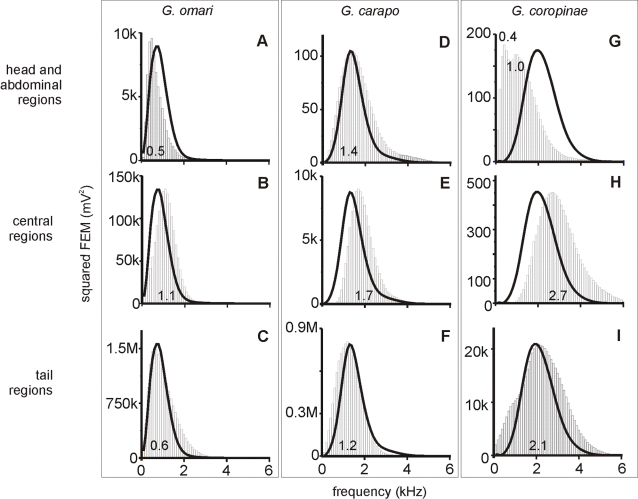
Different regions have a different spectral density.Power spectral density histograms showing that in all species the highest frequency wave components are generated at the central region of the fish's bodies. The modes of these histograms (peak power frequencies) are indicated on each plot. The black curves superimposed to the histograms are the envelopes of the power spectra of the head to tail electric organ discharge of the same fish normalized to the peak of the histogram for shape comparison. Note that in the two tropical species (G. carapo and G. coropinae) the power spectrum is shifted to a high frequency range, and that G. coropinae has two modes at the rostral region.